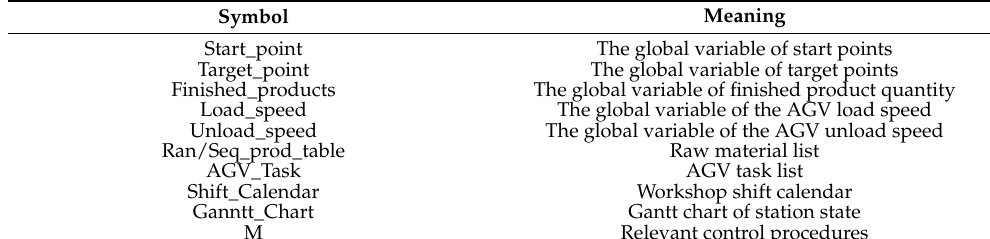
Figure 10. The simulation analysis model of an assembly line. Table 3. The symbols and meanings of the simulation analysis model.